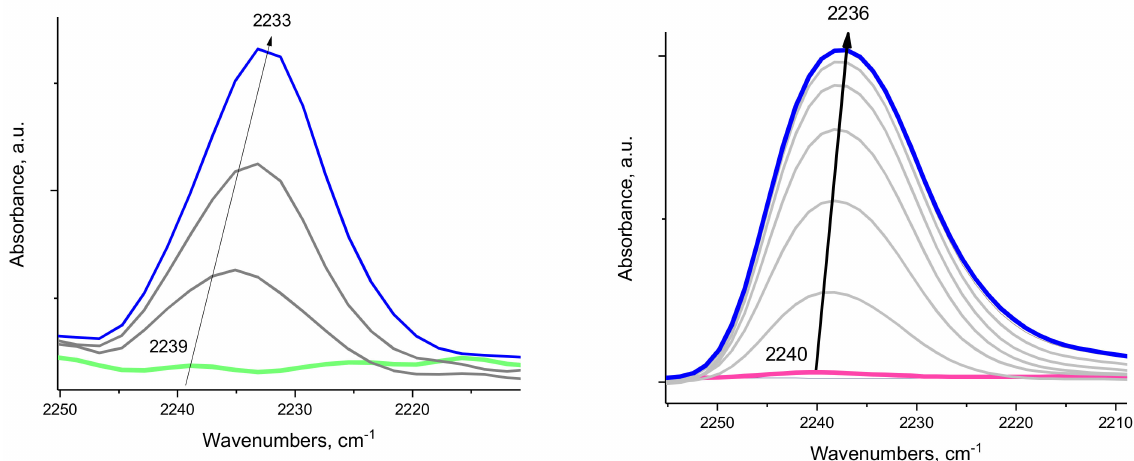
Figure 4. ( Left ) FTIR during sequential CO adsorption (~1 Torr) on a steamed H-MFI sample after dehydroxylation at 500 ◦ C. ( Right ) FTIR during sequential CO adsorption (~1 Torr) on a rod-like gamma alumina sample after dehydroxylation at 500 ◦